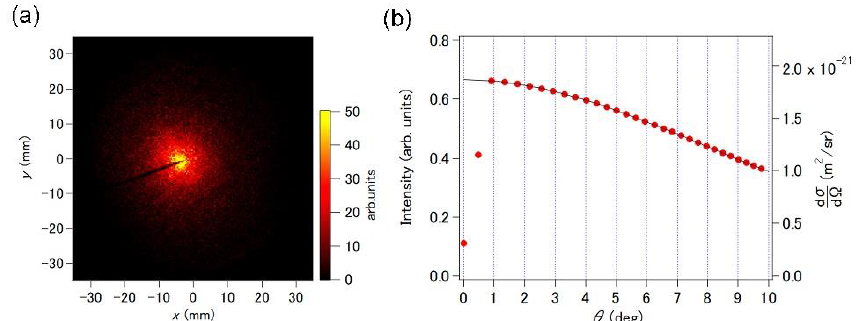
Figure 8. ( a ) An image of the scattering electrons at the incident electron kinetic energies of E i = 1000 eV scattered by He atoms in the absence of laser fields. ( b ) Experimental differential cross sections (DCSs) (red filled circles) and a theoretically calculated DCS curve [26] (black solid curve) for electrons elastically scattered by He atoms.